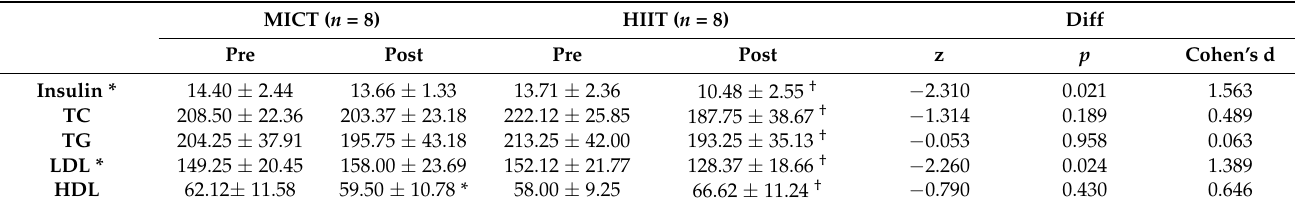
Table 5. Responses on blood sugar and blood lipid for MICT and HIIT groups.